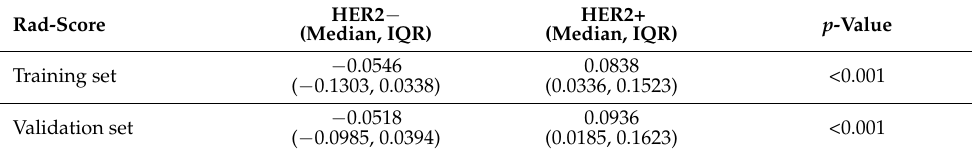
Table 3. Rad-score for the training and validation sets.